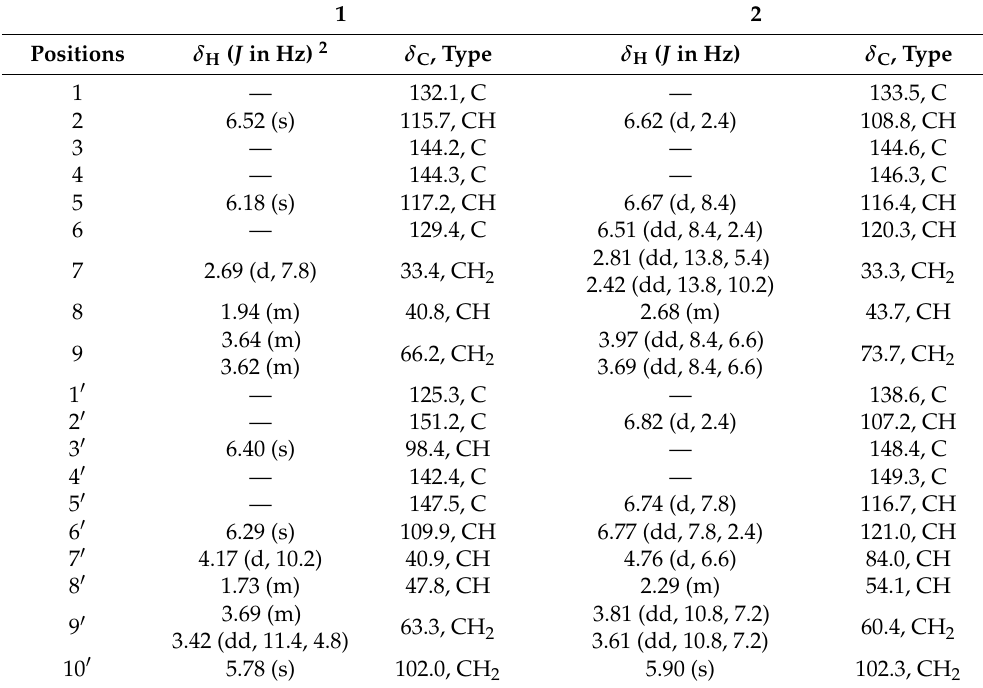
Table 1. 1 H and 13 C NMR data of compounds 1 and 2 in CD 3 OD 1 .